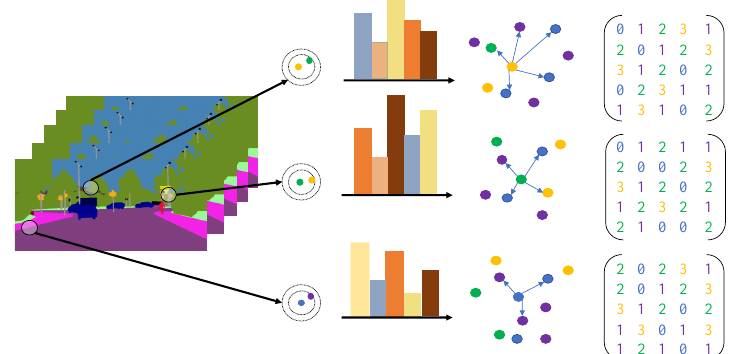
Figure 5. Our proposed semantic descriptor is based on semantic information and its distribution. The semantic segmentation network extracts high-level semantic information at different levels and selects the feature points with the most significant changes in semantic information as key points. The semantic information distribution of its neighborhood is analyzed for key points, and the semantic descriptors are represented in matrix form.